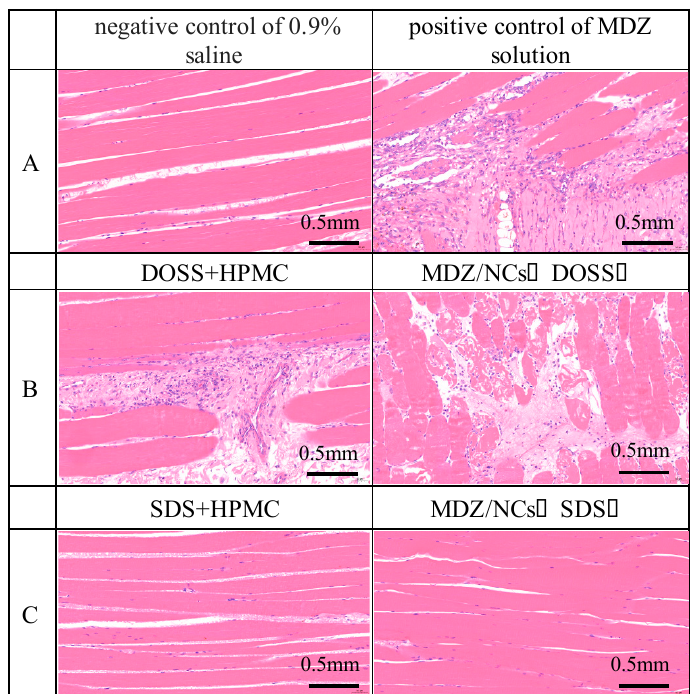
Figure 2. Comparison of muscle irritation with different formulations in rabbits. ( A ) control group: negative control with 0.9% saline; positive control with an MDZ solution with pH 2; ( B ) DOSS + HPMC; MDZ/NCs (DOSS); ( C ) SDS + HPMC; MDZ/NCs (SDS).